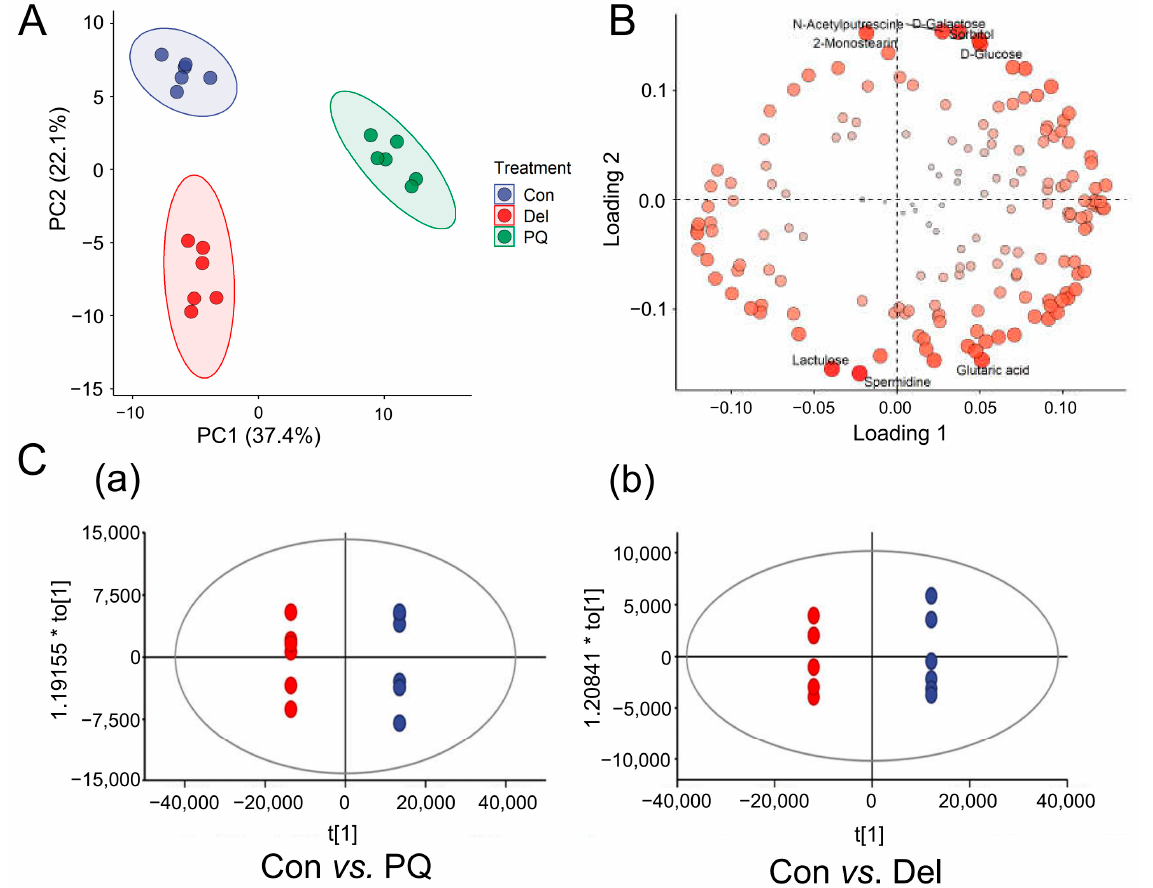
Figure 2. Multivariate statistical analysis of different treatment groups. ( A ) PCA score plot. Variance of PC1 was 28.5%, and variance of PC2 was 19.6%. ( B ) PCA loading plot. ( C ) Score plot from OPLS-DA models. ( a ) PQ vs. control group and ( b ) Del vs. control group.